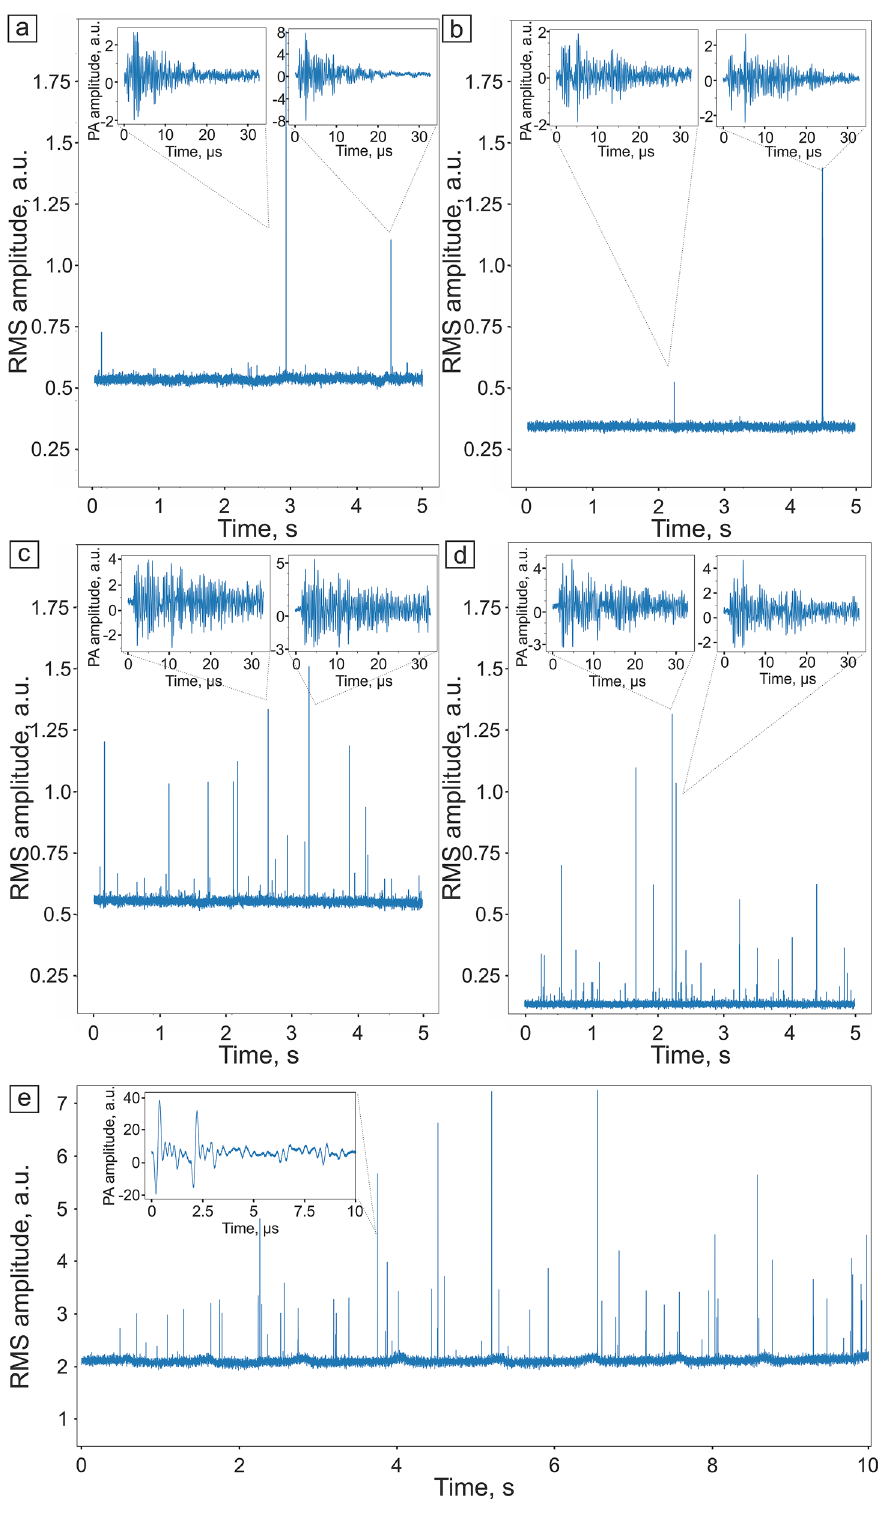
Figure 6. PA traces with signal waveform examples. ( a ) Human blood containing B1610 melanoma cells, ( b ) human blood containing melanoma cell phantoms, ( c ) hemoglobin solution containing melanoma cell phantoms, and ( d ) RBC phantoms’ suspension containing melanoma cell phantoms. Laser pulse energy, 100 µJ. ( e ) Mouse femoral vessel containing B16F10 in vivo. The insets show the examples of single